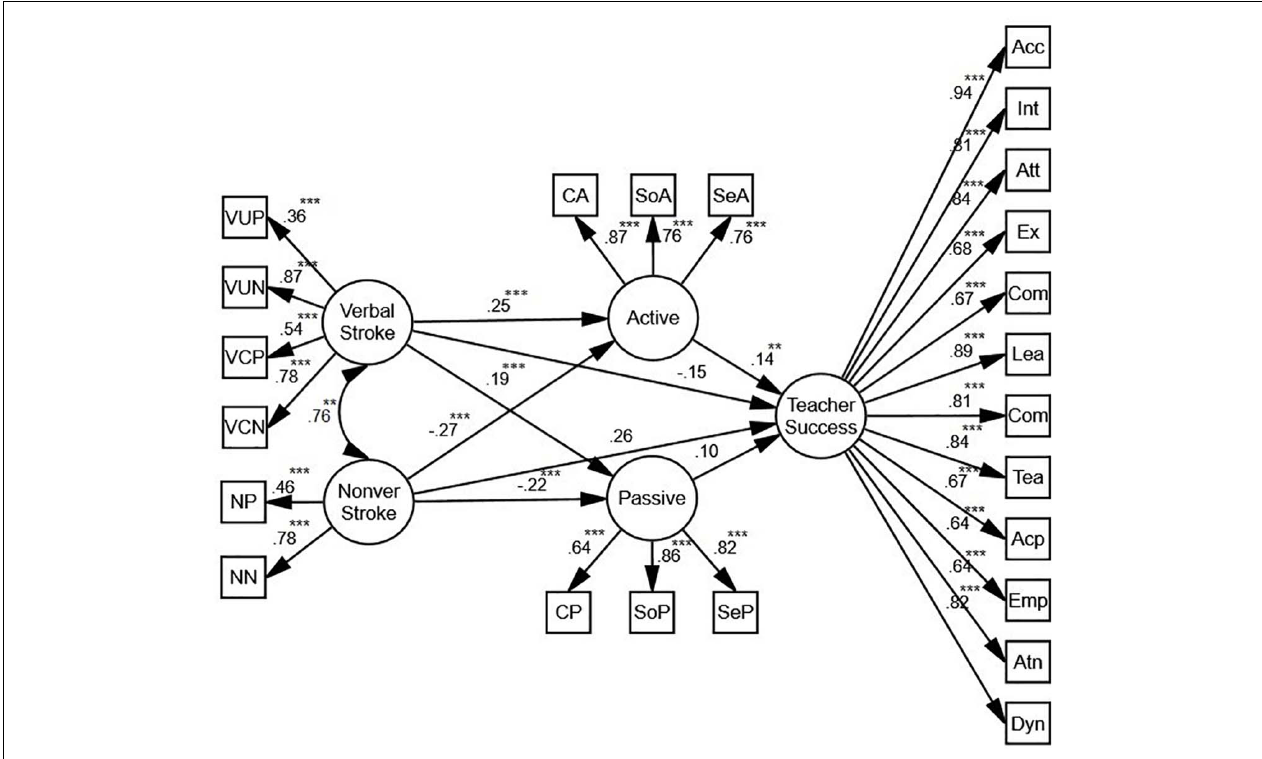
FIGURE 6 | The schematic representation of the relationships between verbal and nonverbal (nonver) stroke, active and passive motivation, and teacher success (** p < 0.01, *** p <